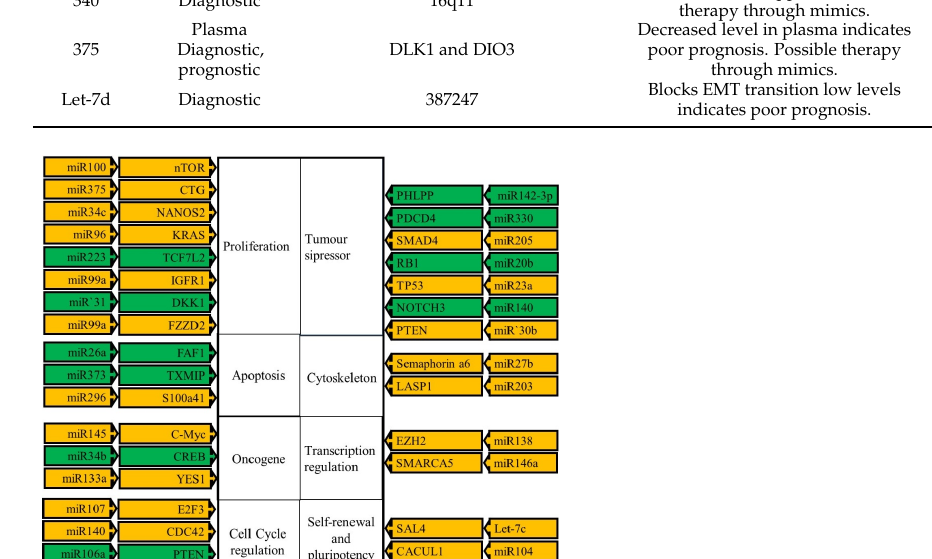
Indicates good prognosis and predicts nonresponse to treatment. Tumor suppressor. Possible therapy through mimics. Downregulated. Possible therapy through mimics. Indicates poor prognosis and predicts nonresponse to treatment. Indicates poor prognosis. Possible therapy through mimics. Tumor suppressor. Tumor suppressor. Downregulation is an indicator of poor prognosis and predicts lack of response to treatment. Downregulation is associated with poor prognosis. Tumor suppressor. Possible therapy through mimics. Downregulation indicts poor prognosis. Possible therapy through mimics. Acts as a tumor suppressor. Possible therapy through mimics. Decreased level in plasma indicates poor prognosis. Possible therapy through mimics.